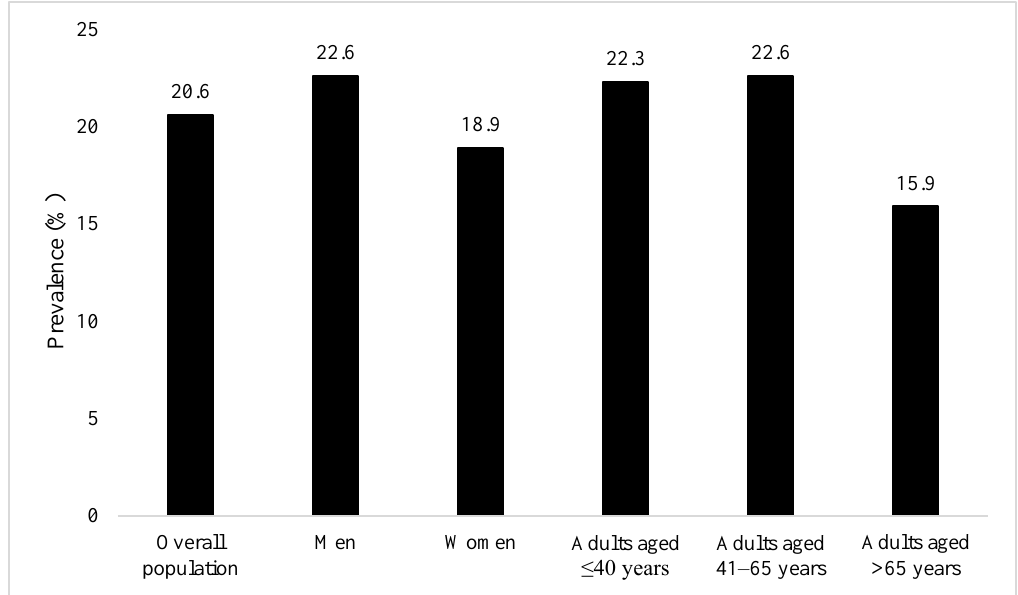
Figure 1. Prevalence of dental caries in the overall population and by sex and age.